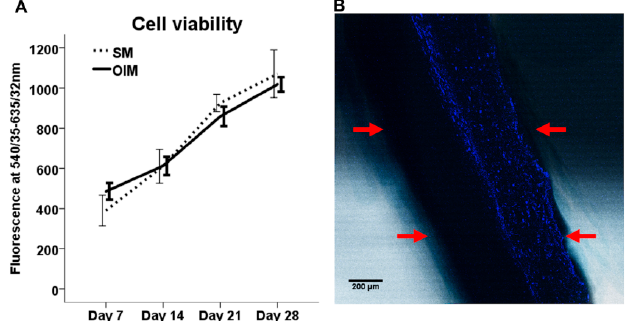
Figure 2. ( A ) Cell viability of hES-MPs on single layer electrospun PCL scaffolds with SM and OIM media, measured after 7, 14, 21, and 28 days, mean ± SE, n = 6; ( B ) Tri-layer scaffold, located by DIC